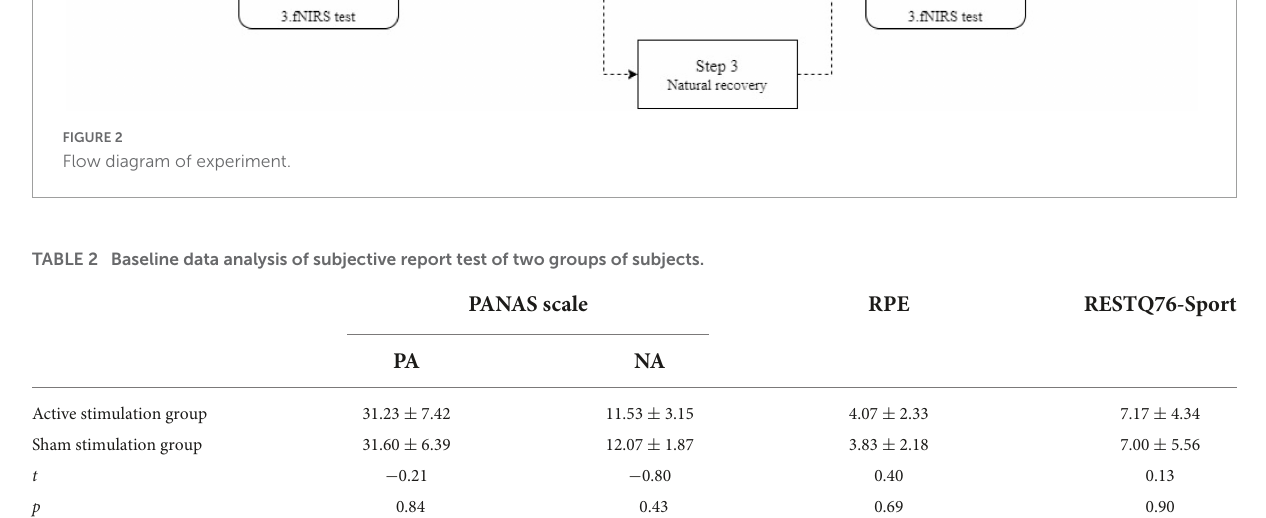
FIGURE2 Flow diagram of experiment.